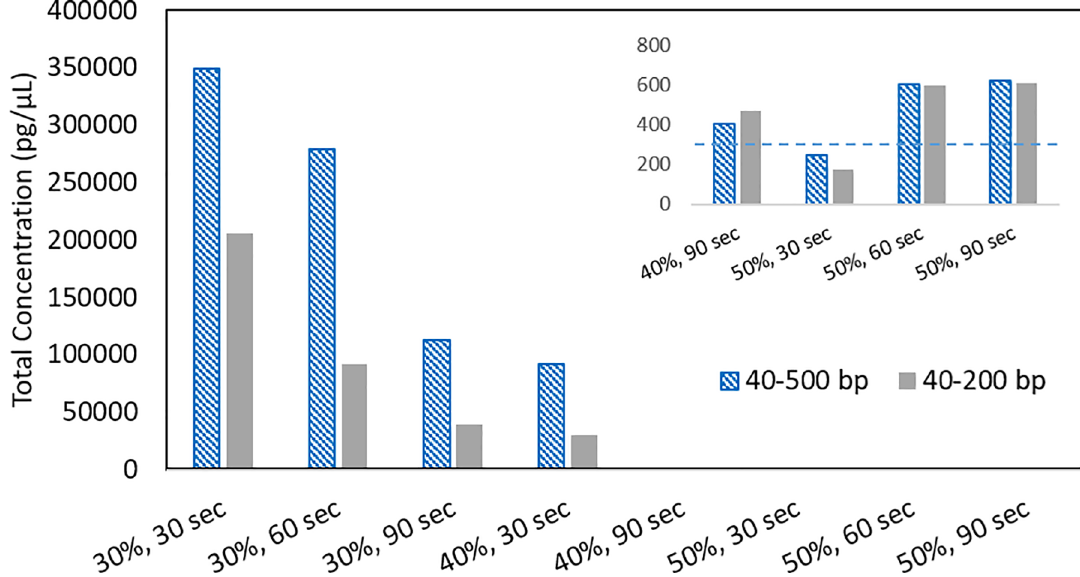
Fig 4. Microwave cellular lysis visualization using a mini-gel instrument. Aligent 2100 Mini-gel Bioanalyzer analysis of L . monocytogenes lysate microwave lysed with Lyse-It 1 . As the power and the time of the microwave increases the overall DNA concentration decreases indicating more continues shearing (cutting) of genomic DNA, to smaller and smaller sizes.